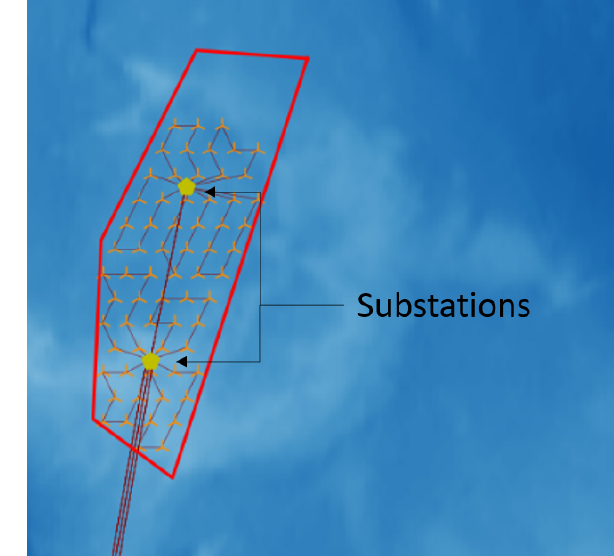
Figure 3. Close-up view of the farm.